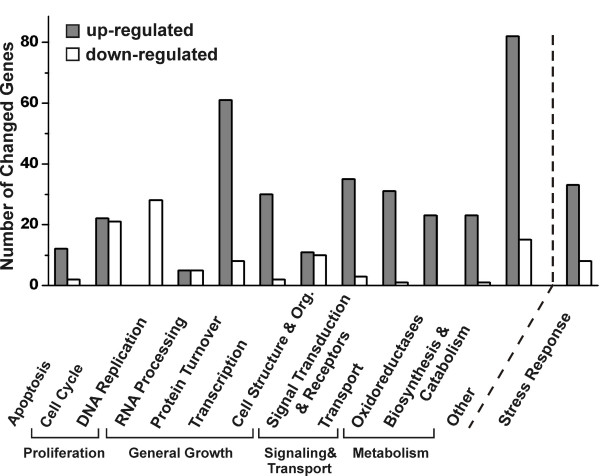
Functional categories of genes regulated in MCF-7 cells after 24 h incubation with black cohosh extract. Genes were grouped in 5 large groups (Apoptosis, Proliferation, General Growth, Signaling & Transport, Metabolism), some consisting of subgroups. Genes that are not clearly associated with these groups are summarized in the category others. The category stress response contains genes also grouped into one of the 6 main classes. Each bar represents the number of genes that were up- (dark) or downregulated (white) in the respective group.